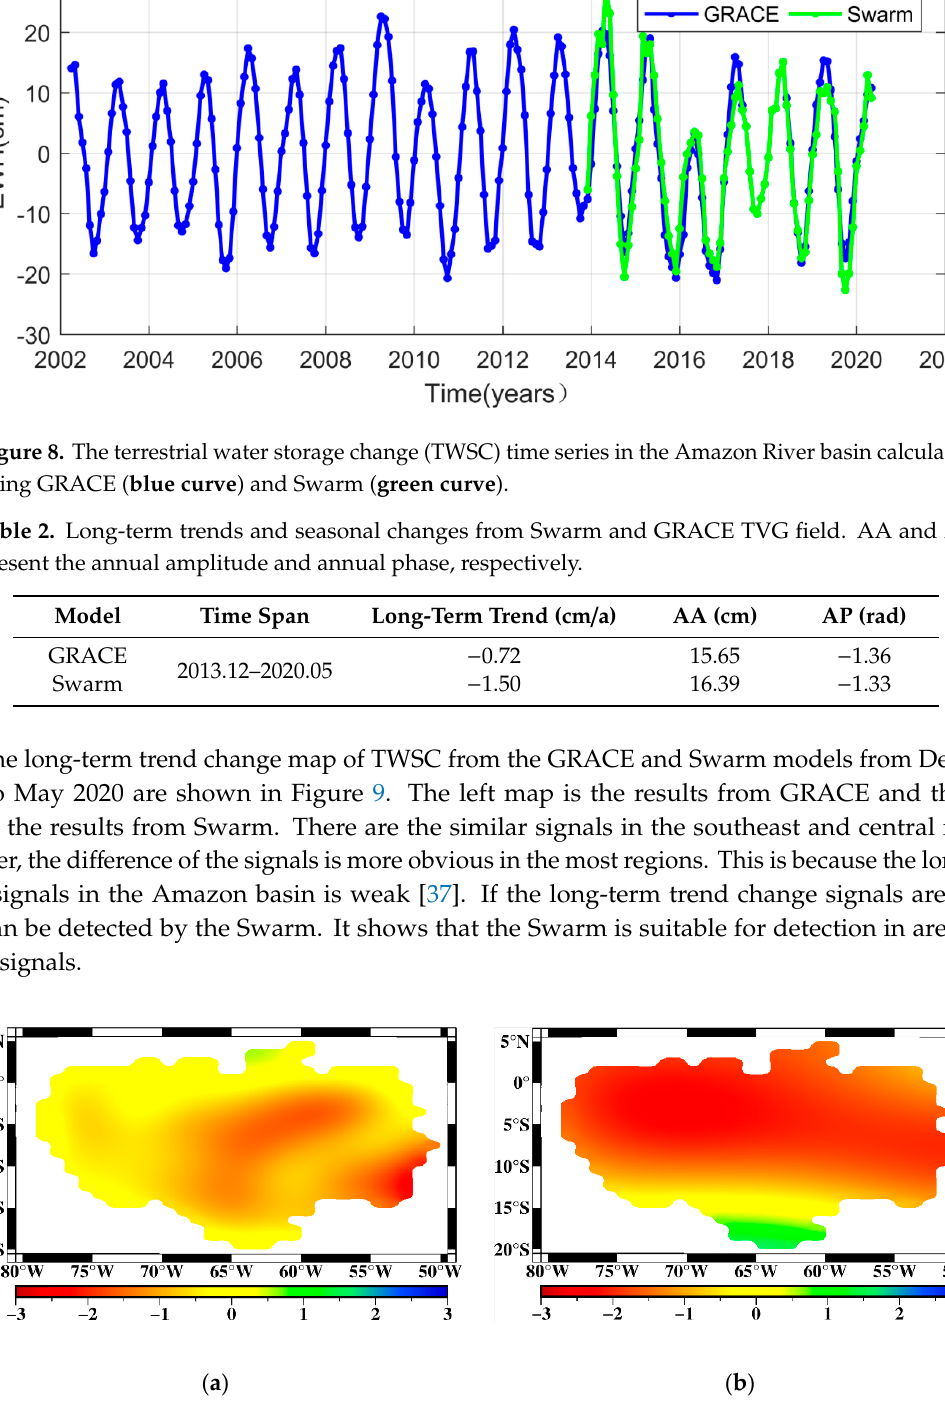
Table 2. Long-term trends and seasonal changes from Swarm and GRACE TVG field. AA and AP present the annual amplitude and annual phase, respectively.